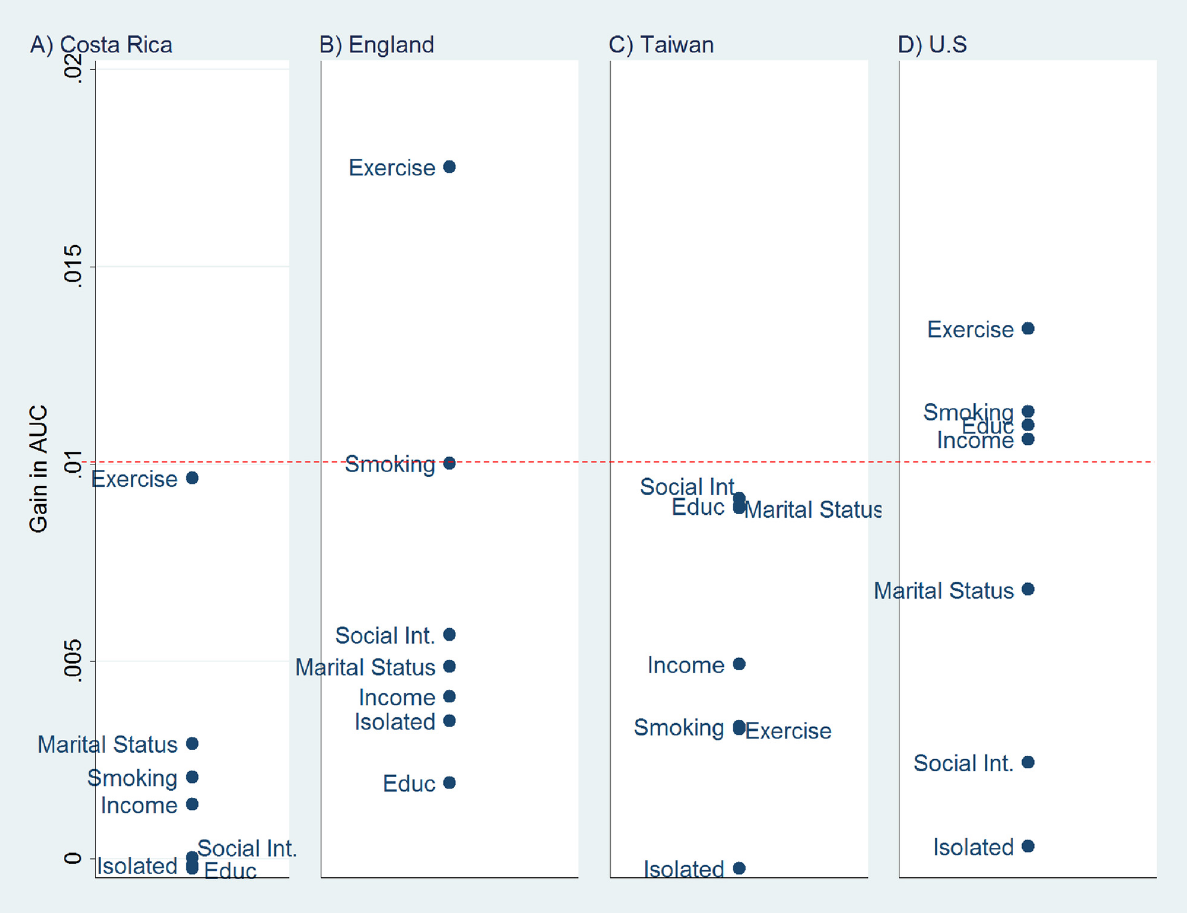
Fig 2. Environmental Predictors of Five-Year Mortality After Adjustment for Age and Sex, Ranked by the Gain in AUC, A) Costa Rica, B) England, C) Taiwan, and D) the U.S. Abbreviations: Educ, Educational attainment; Social Int., Social